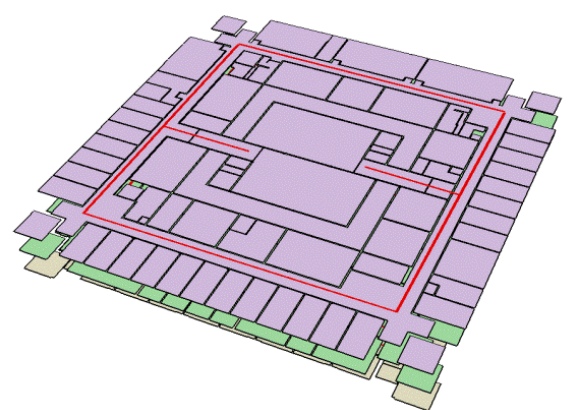
Figure 4. 3D floor plans and hallways of PSEB